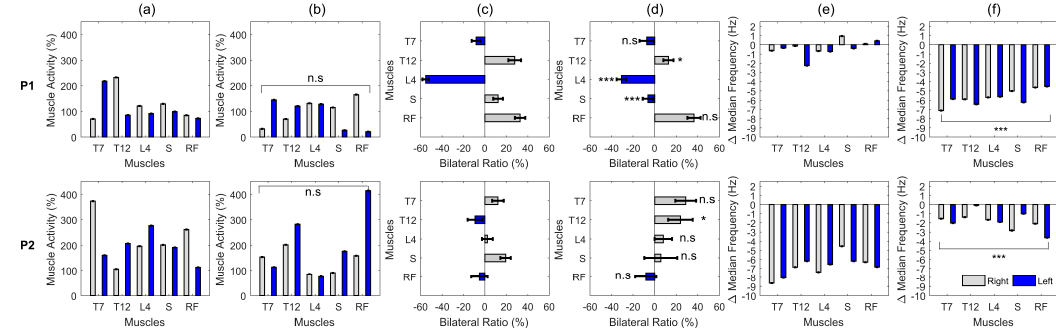
Figure 2. Example of acquired signals from the patients: plantar pressure, gait phase, gain variation (G), knee angle and knee torque. IC, initial contact; MS, mid stance; FS, final stance; SW, swing. ( a ) signals from P1; ( b ) signals from P2; ( c ) signals from P3.